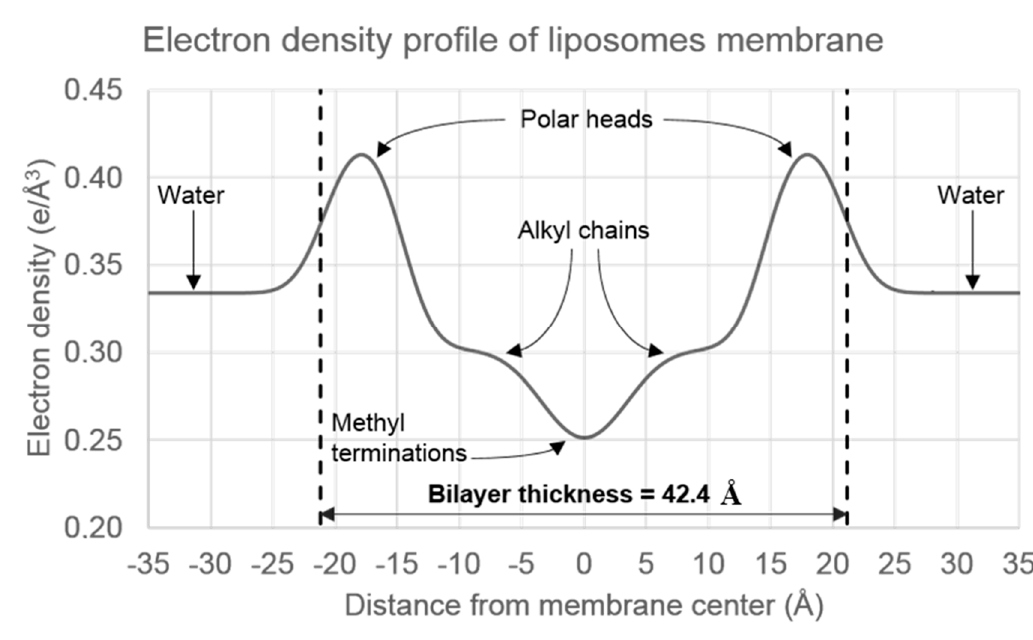
Figure 5. Electron density profile of the bilayer of unilamellar liposomes, according to the best fit of the experimental scattering diffractogram.